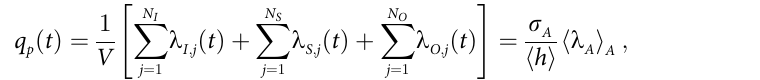
Fig 6. Multiplicity’s impact on infection risk. Plots of mean infection risk ( R aerosols have the same number of pathogen copies in them k . (Left) The infection risk as a function of k for fixed average dose h Δ i = r − 1 for different single pathogen infection probabilities r . (Right) The infection risk as a function of the dose scaled by r ( h Δ i r ) for different k and the same fixed r = 10 − 2 ( r − 1 =